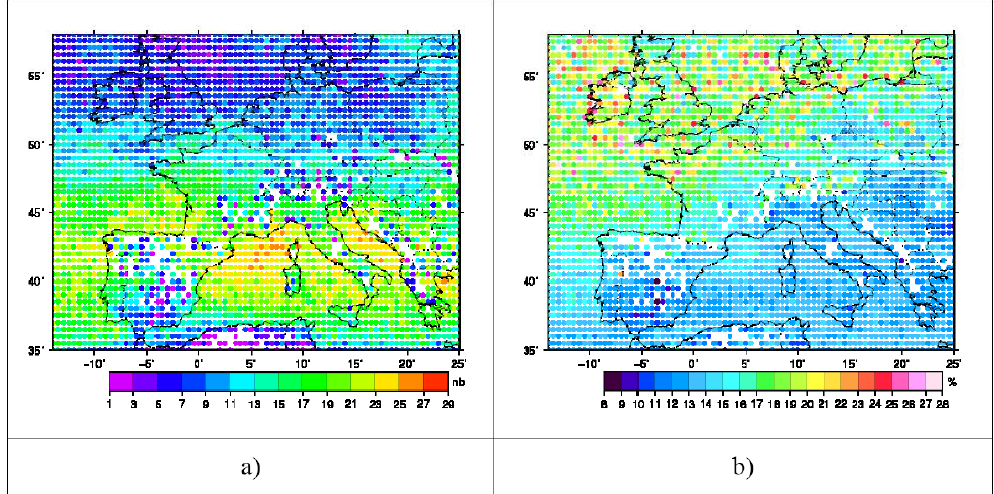
Fig. 1. (a) The spatio-temporal distribution of days when at least one pixel was available for assimilation for a given grid cell (maximum of 30 days i.e. number of days included in the assimilation experiment, color scale varying from violet to red: violet represents relatively low values and red relatively high values) and (b) the mean relative error (expressed in percent %) of the IASI inversions (error calculated on the ozone partial columns 0–6km) averaged over the month of July 2007 (black represents relatively low values and pink relatively high